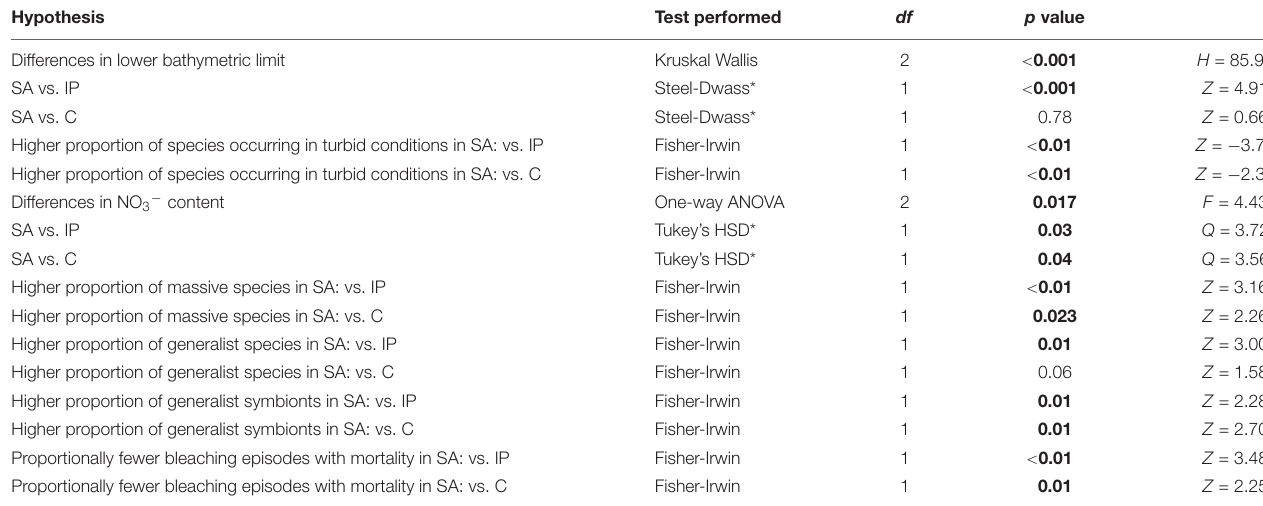
TABLE 1 | Results for statistical tests investigating differences in six different aspects associated with thermal tolerance between South Atlantic (SA), Indo-Pacific (IP), and Caribbean (C) coral reefs. Hypothesis Test performed df p